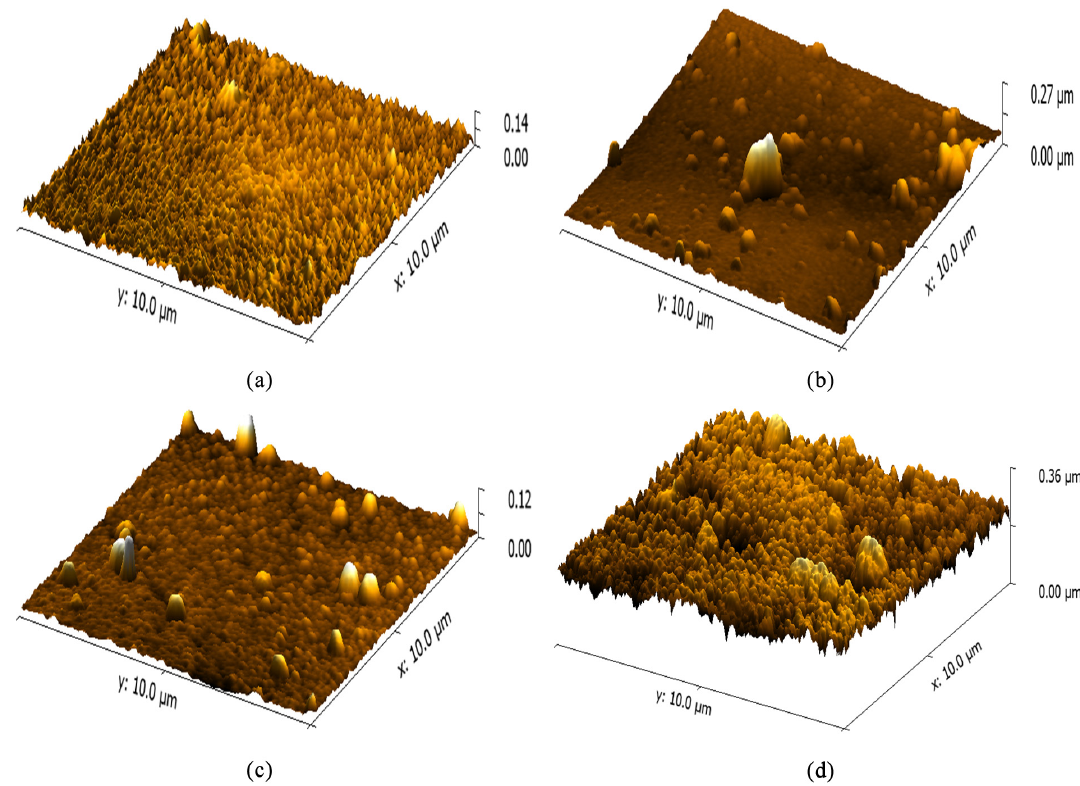
Figure 2. AFM images of the (a) sample 1, (b) sample 2, (c) sample 3, and (d) sample 4.